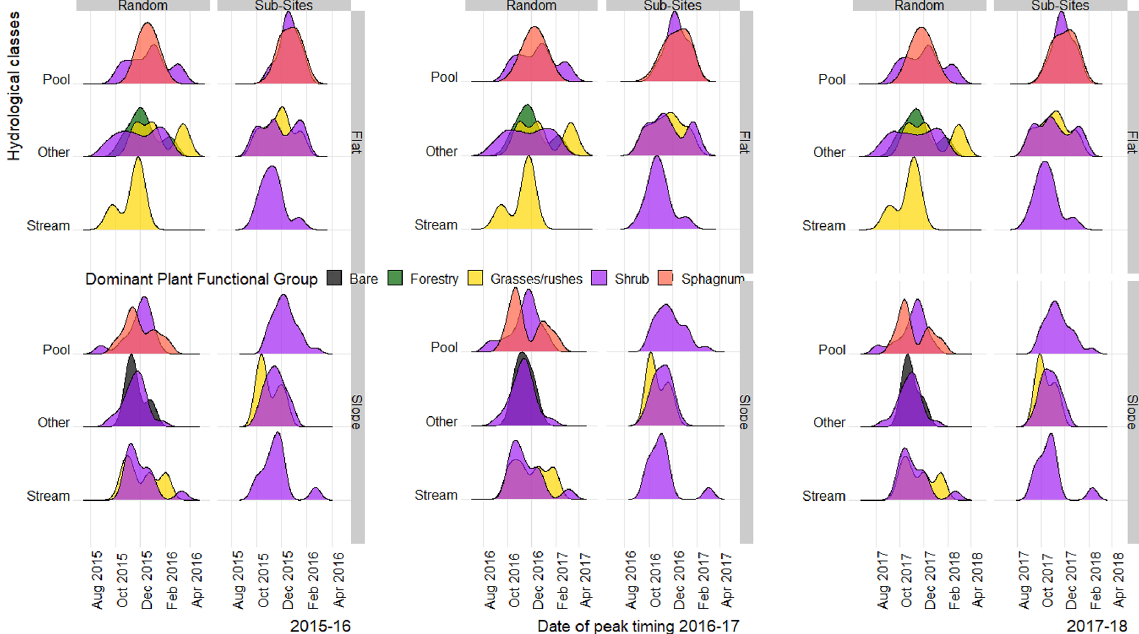
Figure 4. Distribution of mean peak timing date by dominant plant functional clusters for polygons with pools, streams, or other hydrological features (e.g. drains, erosion gullies, peat cutting, or no apparent features) in either a flat (gradient < 1.5 ◦ ) or slope (gradient > 1.5 ◦ ) topo- graphic setting for the random and sub-site polygons. Plant functional group polygons ( n random/sub-site): bare – bare peat (6 / 2); forestry – conifer plantation (12 / 3); grasses and rushes – grass-dominated communities (13 / 14), typically Molinia caerulea ; shrub – shrub-dominated communities (59 / 77), typically either or both of Calluna vulgaris and Erica tetralix ; Sphagnum – Sphagnum -dominated communities 35 / 34. Sedges, rushes, and other mosses are also present, often as co-dominant species in both Sphagnum and shrub communities (see Table